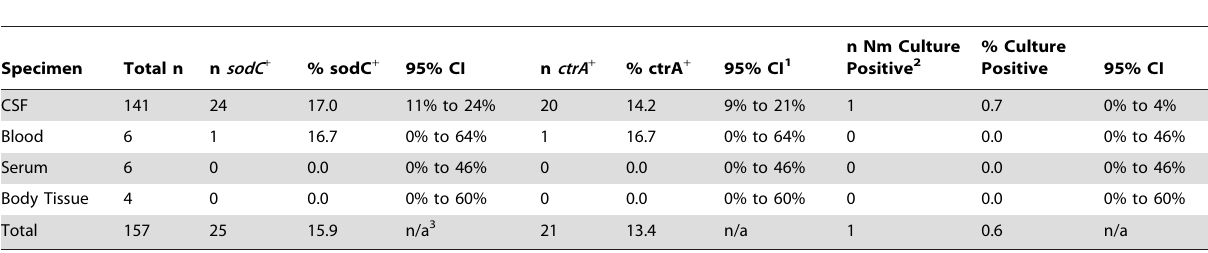
Table 3. U.S. and Turkey clinical specimens tested for sod C and ctrA and compared to culture.